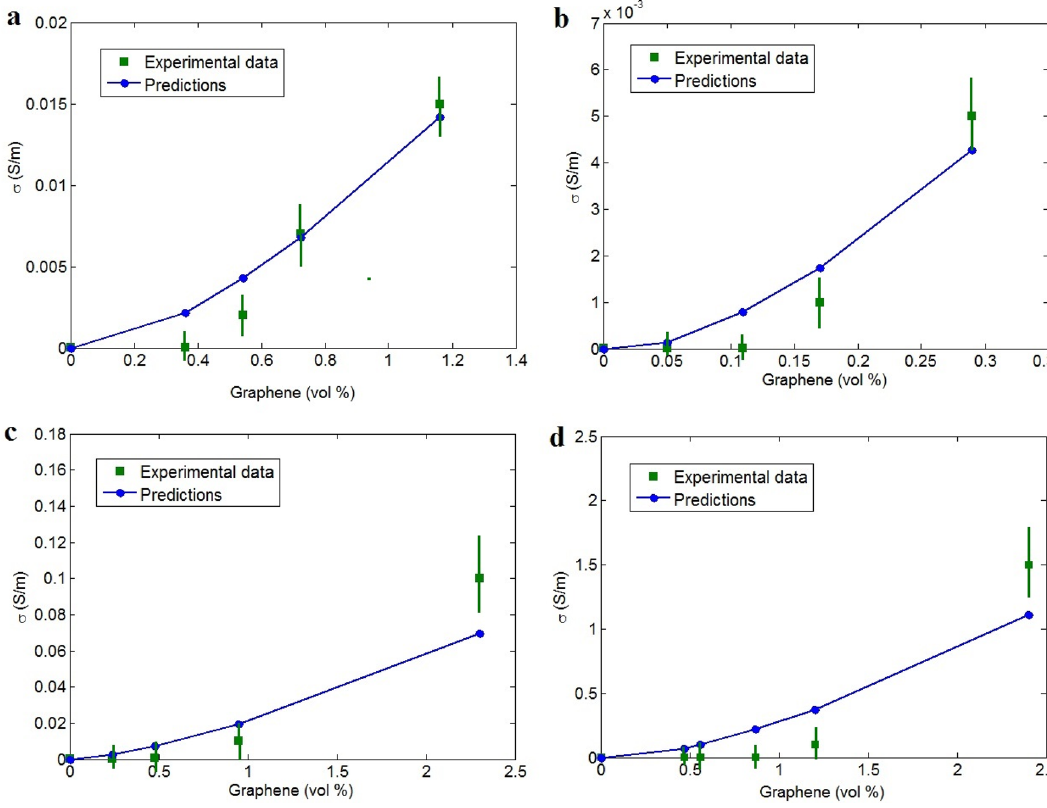
Figure 2. Application of the developed model to estimate the conductivity of ( a ) PVA 67 , ( b ) PI 68 , ( c ) ABS 29 and ( d ) PET 69 graphene systems.